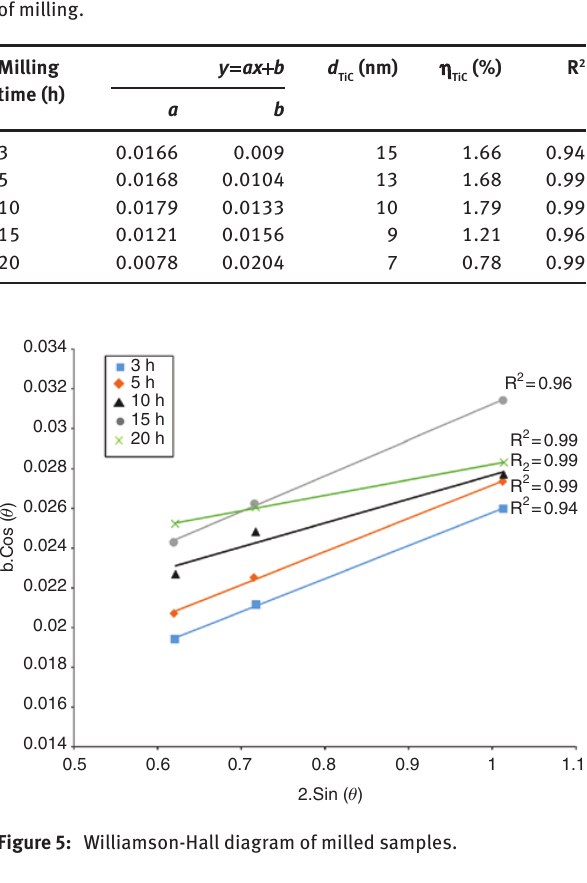
Table 2: Mean size of the particles and the strain caused by milling